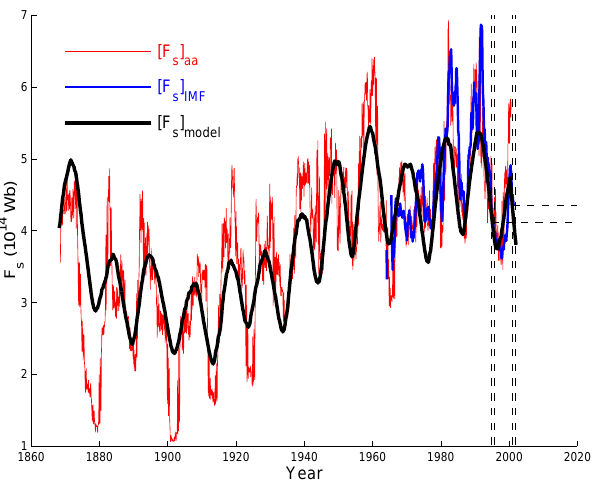
Fig. 3. The variation of open solar flux F s since 1868. The blue line shows monthly means deduced from IMF observations [ F s ] = 2 πr 12 | B r | , whereas the red curve shows 1-year values IMF 1 [ F s ] aa deduced from the aa geomagnetic index using the method of Lockwood et al. (1999) (see Fig. 2 for a more detailed view of the last 3 cycles). The black curve shows the best fit [ F s ] SM using the open flux continuity model of Solanki et al. (2000). The vertical dashed lines mark the times of the two perihelion passes by Ulysses and the horizontal dashed lines the mean open flux deduced during those passes. Note that the model parameters were obtained from a best fit to data for up to 1986 and thus the values for the two perihe- lion passes are predictions that match the Ulysses observations very well in both cases.